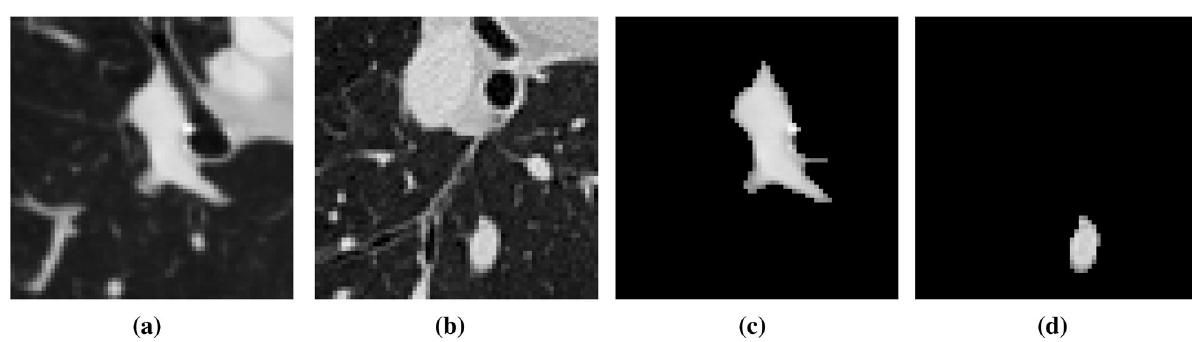
Figure 2. Preprocessing process of negative samples.